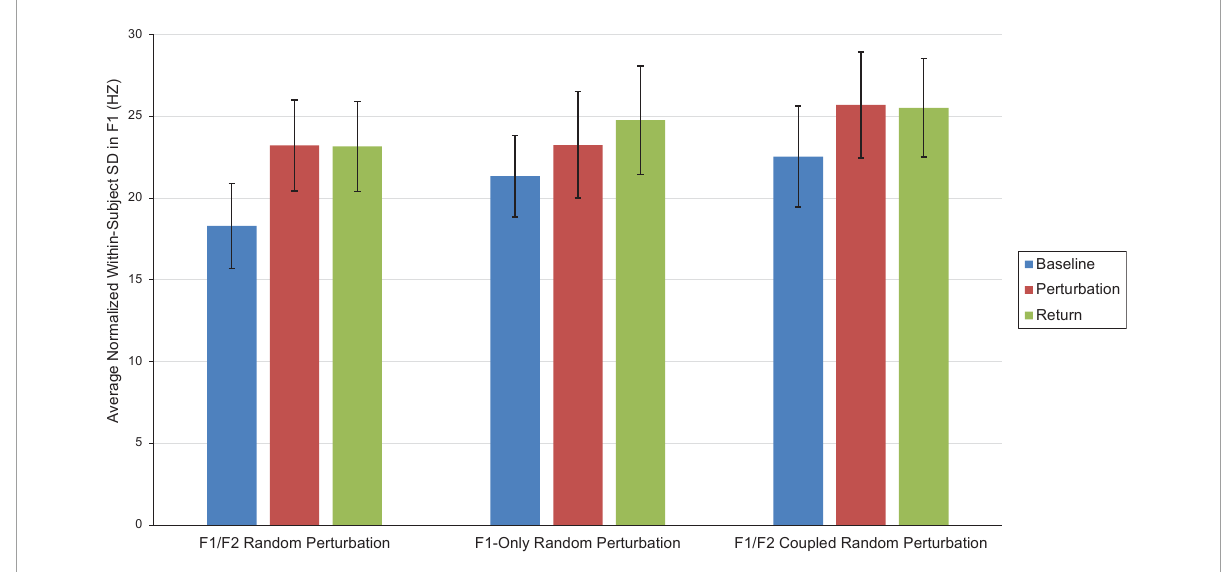
FIGURE4 Average normalized F1 within-subject variability (i.e., SD) in the Baseline (blue), Perturbation (red), and Return (green) phases of the F1/F2 Random Perturbation Condition, F1-Only Random Perturbation Condition, and F1/F2 Coupled Random Perturbation Condition in Experiment 1. Error bars represent 95% confidence